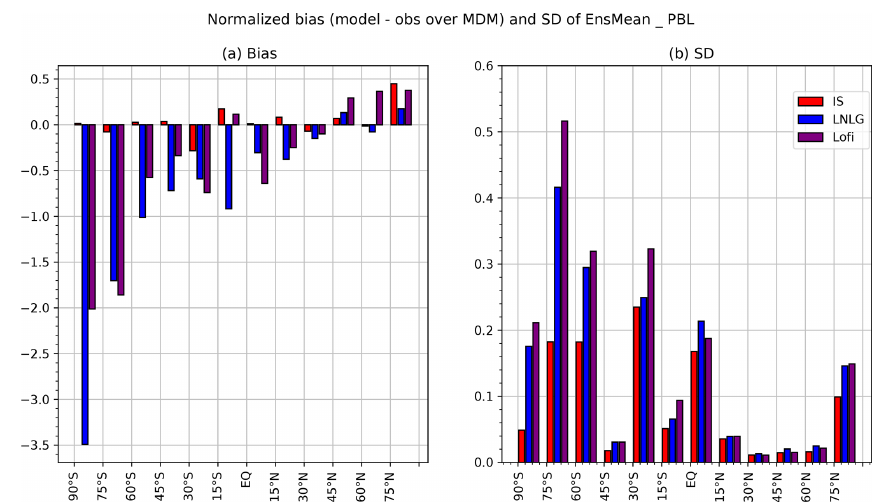
Figure 12. Normalized bias (model minus observation divided by model data mismatch; MDM, see Sect. 2) in (a) and standard deviation in (b) for the ensemble mean of IS (in red), LNLGv9 (in blue), and LoFI (in purple). The evaluation is done by latitude and in the PBL. The data have been averaged over the 4 years of study (2015–2018).